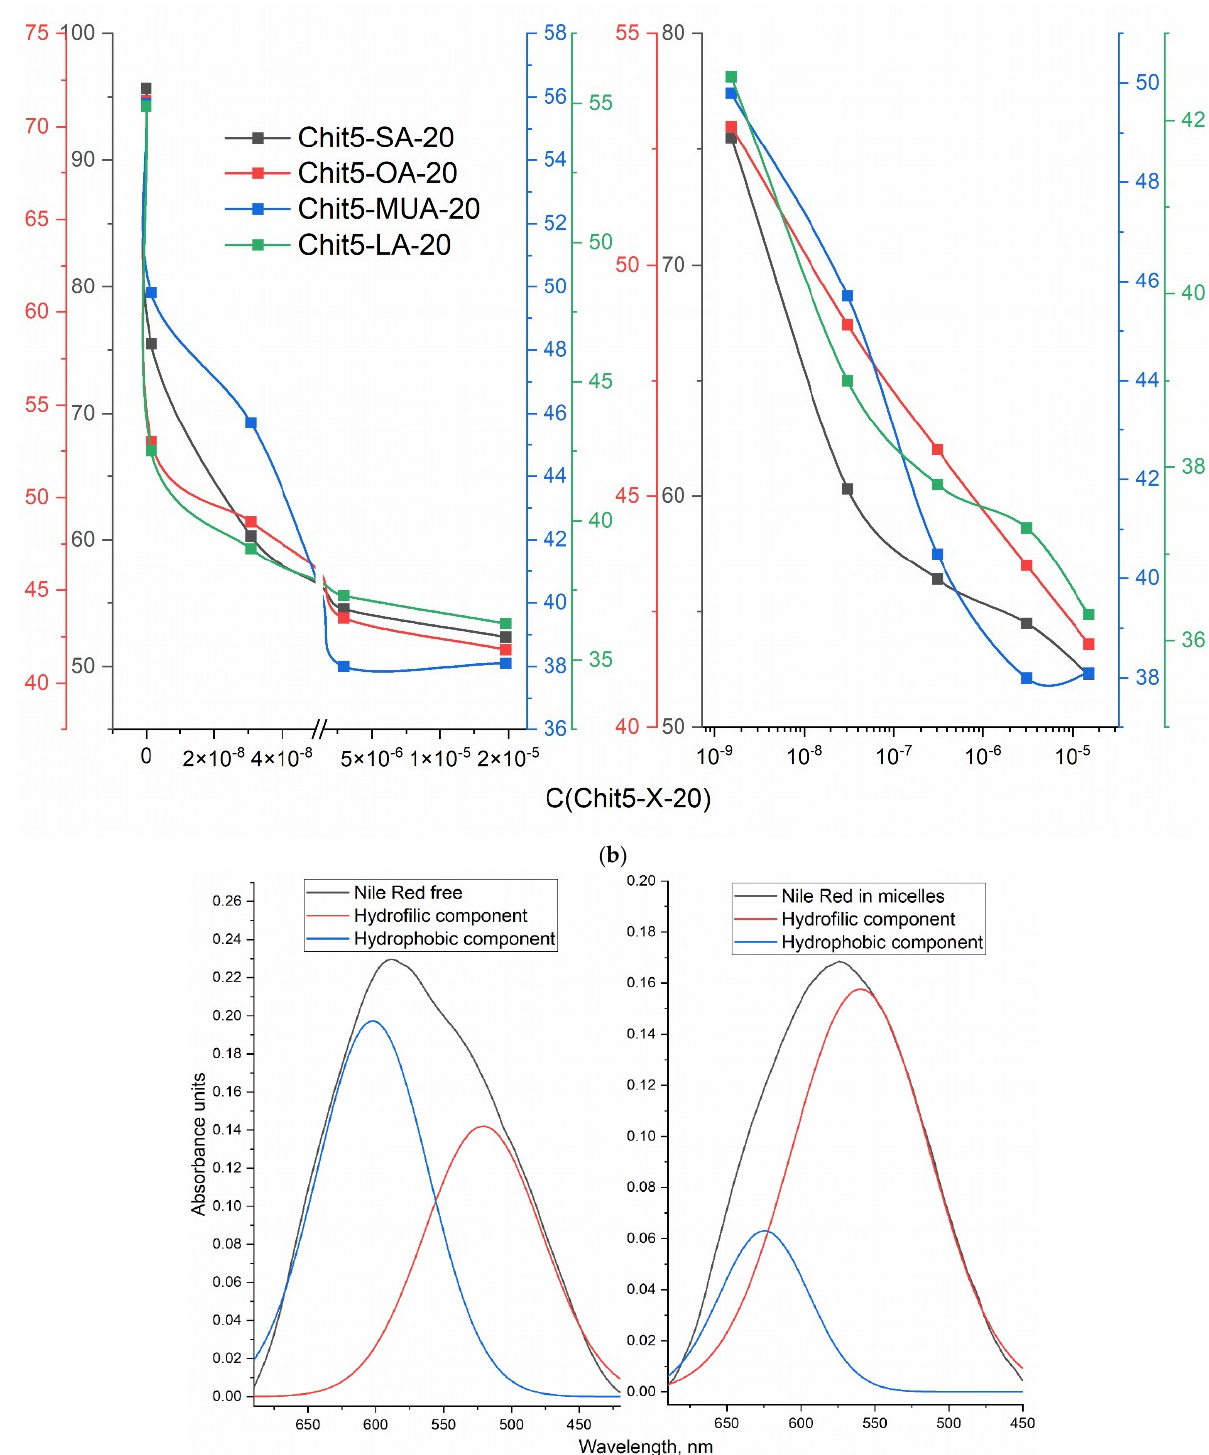
Figure 4. Fluorescence and spectrophotometric determination of the critical micelle concentration with Nile Red dye. ( a ) Fluorescence emission spectra of Nile red, free or with micelles. ( b ) Peak intensities of the spectra ( a ) dependences on the concentration of polymers. λ exci = 490 nm. ( c ) Ab- sorption spectra of Nile red in free state and micellar formulation with corresponding deconvolution into hydrophilic and hydrophobic components with Gaussians. PBS (0.01 M, pH 7.4). Nile Red was dissolved in DMSO (1 mg/mL), followed by × 1000 (or × 100) dilution in